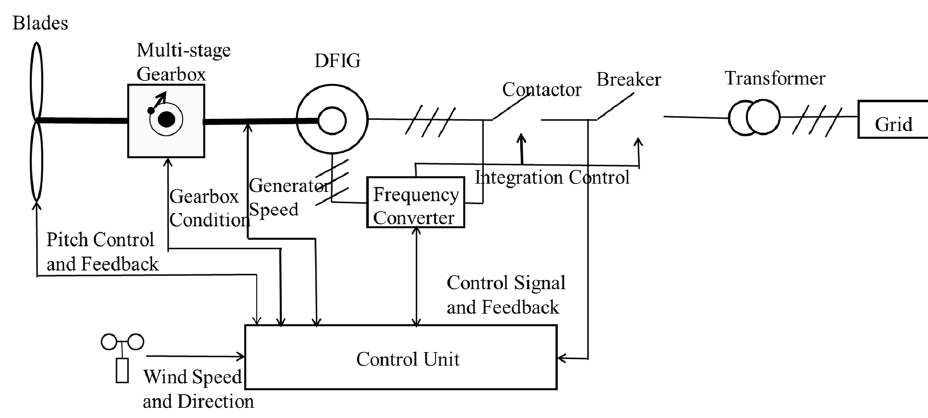
Figure 4. Framework of a wind turbine system.